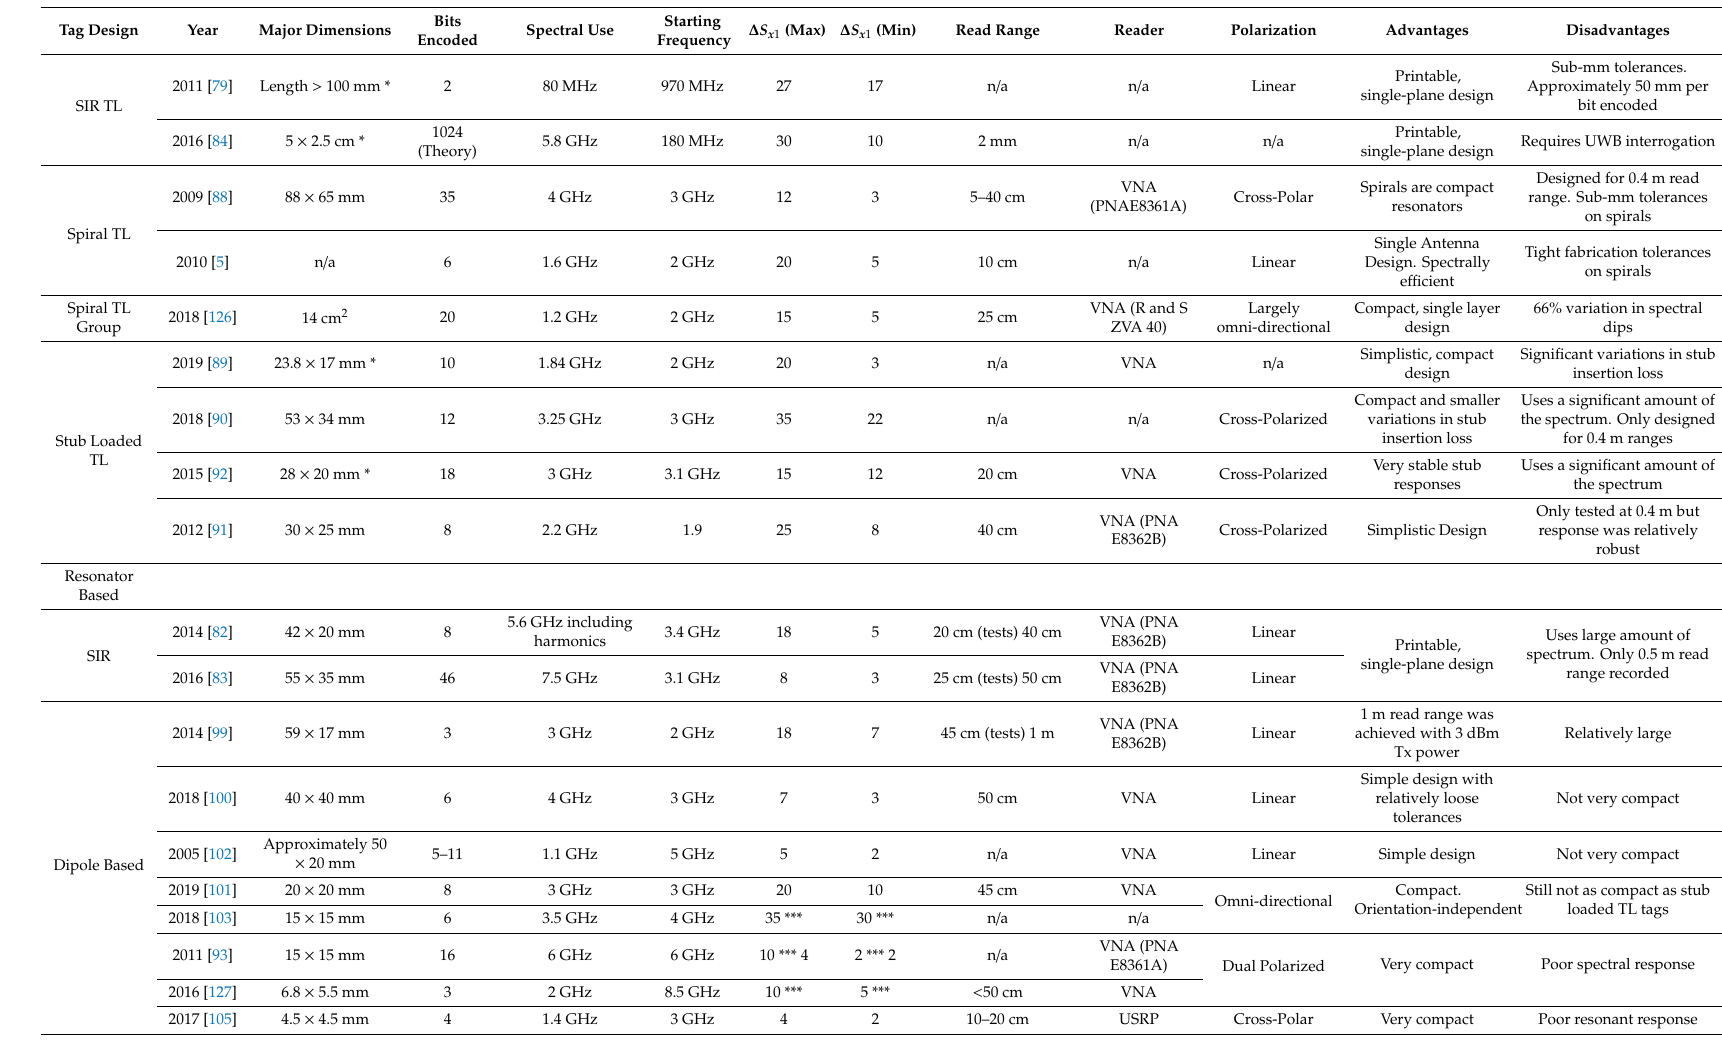
Table 2. Spectral Radio Frequency Identification (RFID) Tag